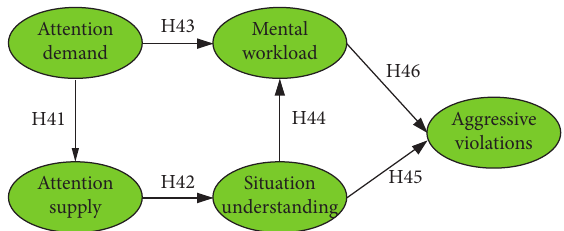
Figure 4: Hypothesis